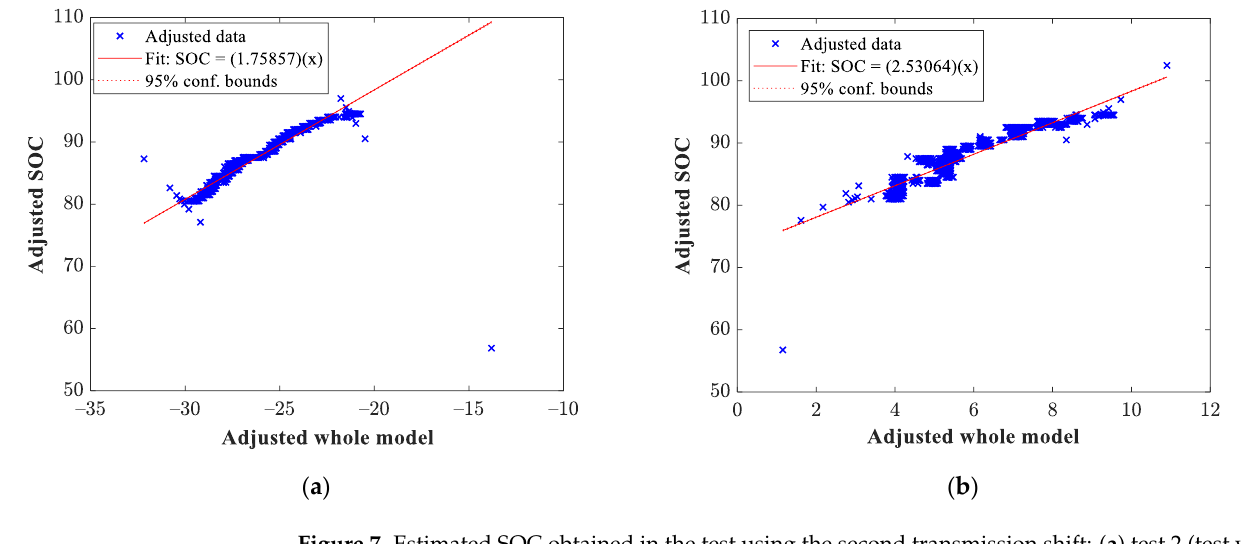
Figure 7. Estimated SOC obtained in the test using the second transmission shift: ( a ) test 2 (test with the lowest RMSE value) and ( b ) test 1 (test with the highest RMSE value).